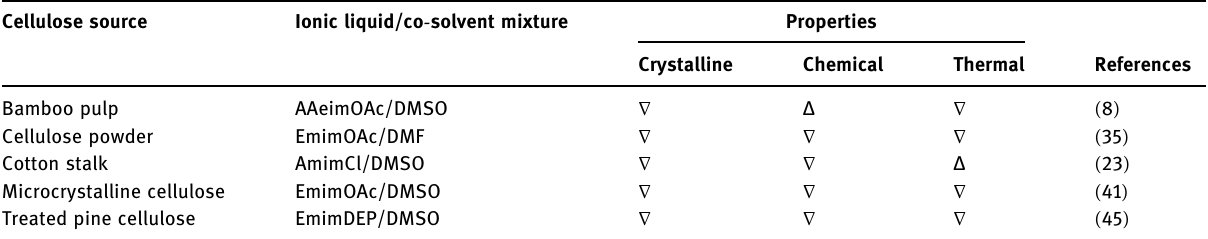
Table 7: Crystalline, chemical, and thermal properties of cellulose regenerated from cellulose/imidazolium - based ionic liquid/co - solvent